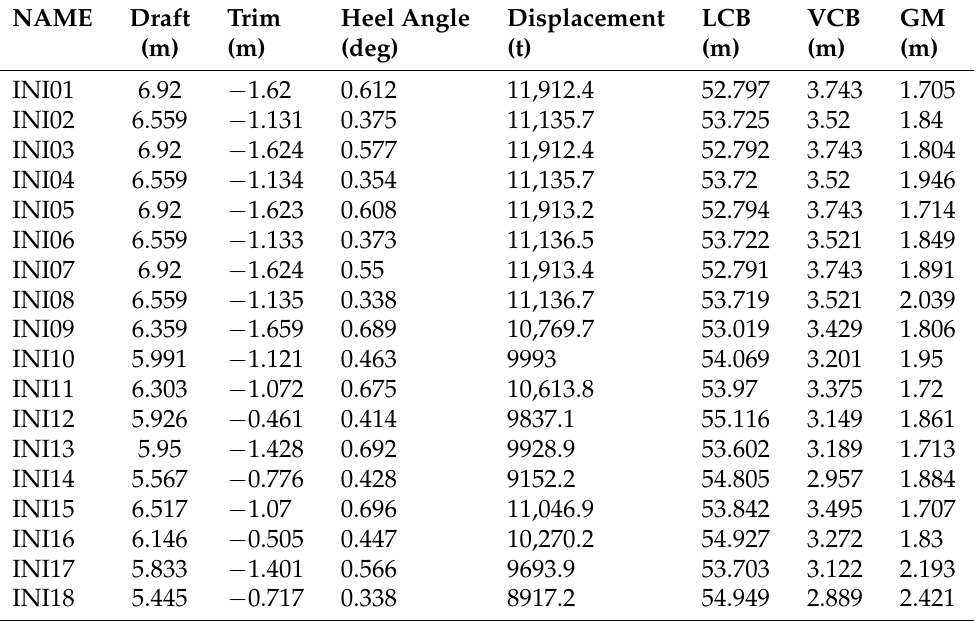
Table 5. Initial ship flotation and stability